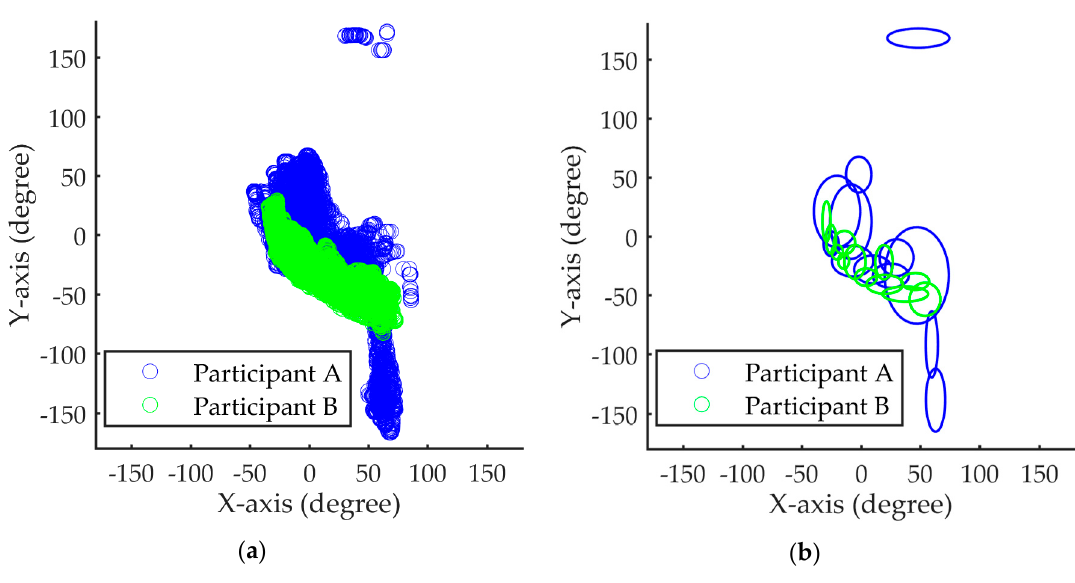
Figure 6. Orientation sensor signals of the driving behaviors from two different participants A and B: ( a ) data distribution signals; ( b ) components of two Gaussian mixture model (GMMs).